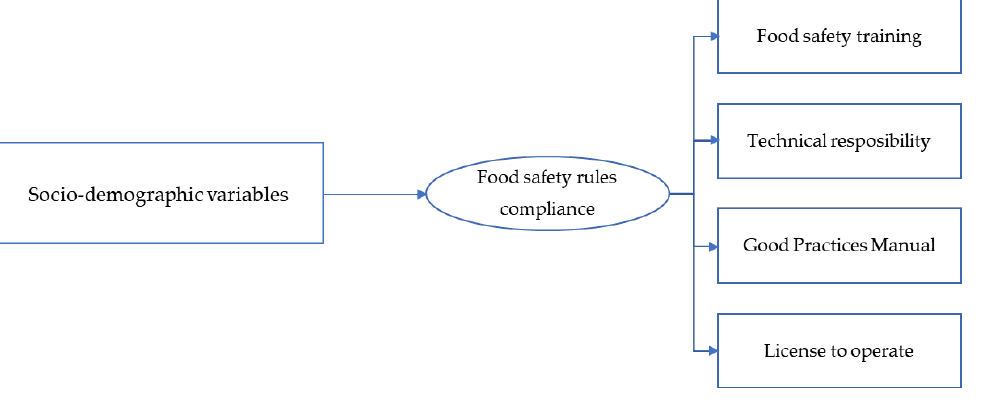
Figure 1. Conceptual framework of the study.